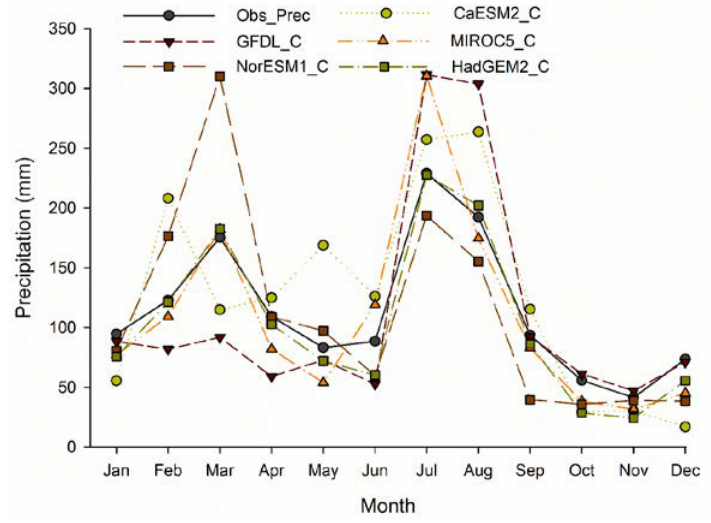
Figure 8. Comparison between observed and GCM precipitation corrected by the PELS method for 1986–2000 in the Jhelum River basin.